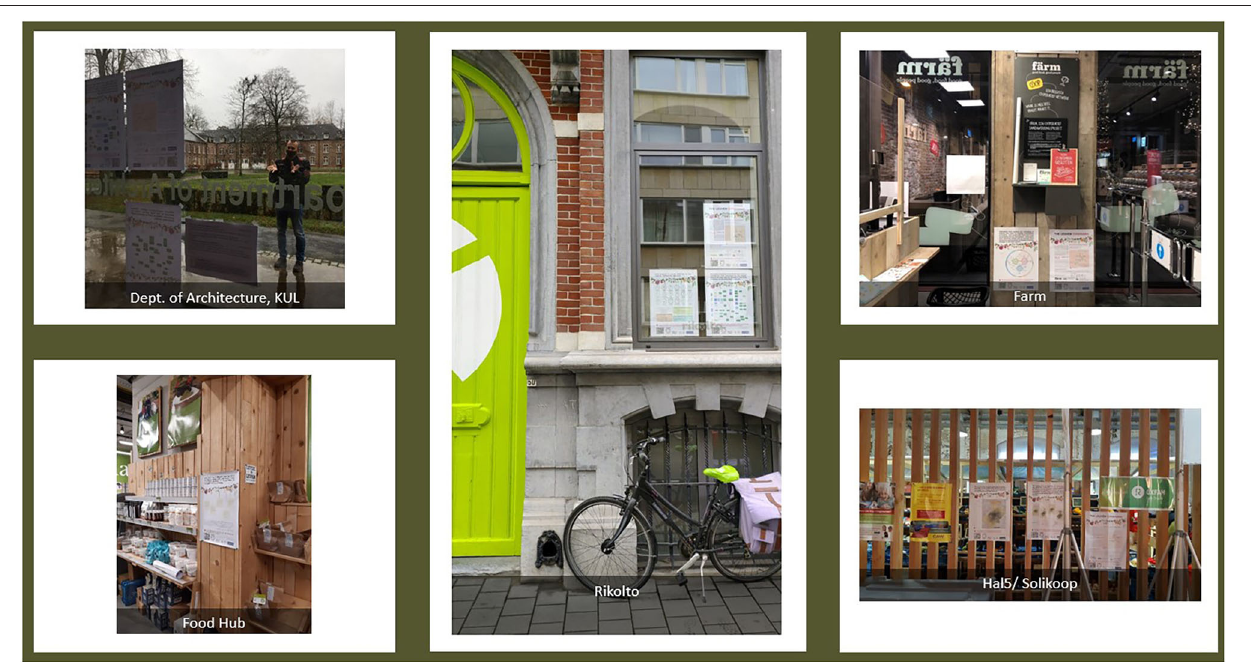
FIGURE 4 | Pictures of the LeuvenGymkhana posters displayed in the premises of different stakeholders of the food system in Leuven between December 2020 and January 2021.